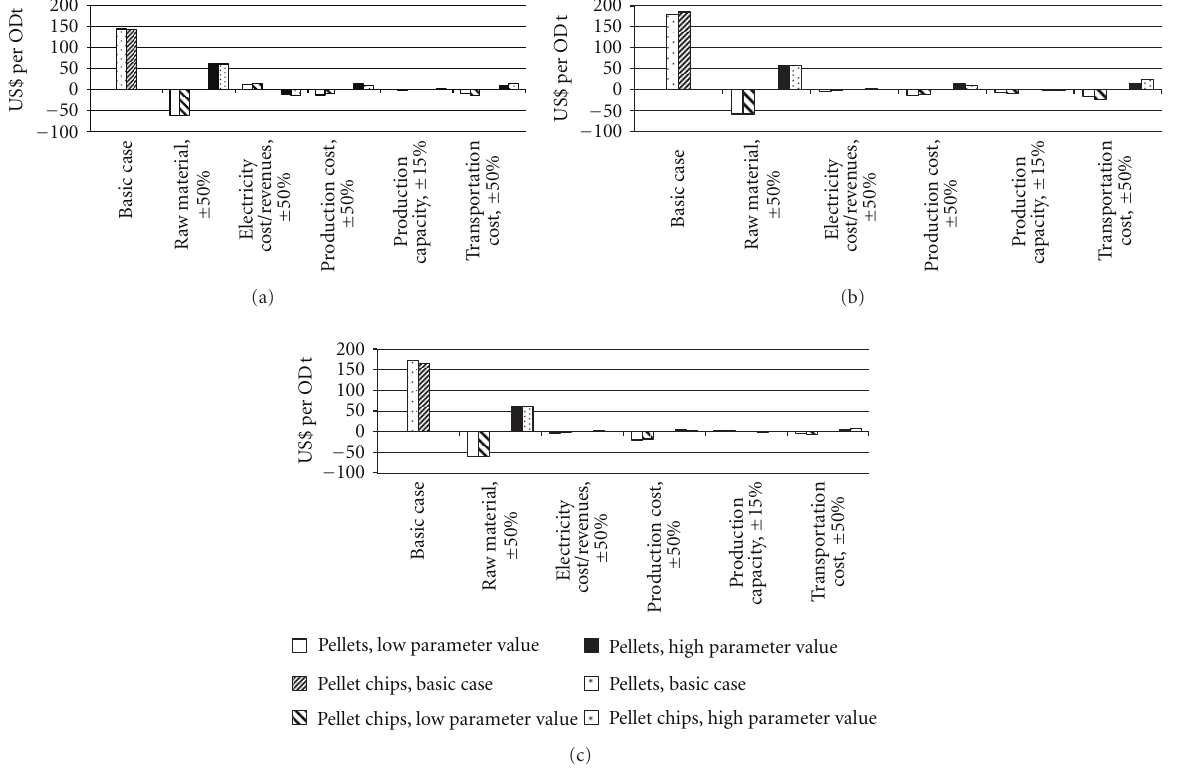
Figure 3: Results of the sensitivity analysis for the three plant sites—Lycksele (a), Vilhelmina (b), and V¨ann¨as (c)—for pellet production (1) and pellet chip production (2). The following parameters were varied: raw material cost, electricity cost/electricity revenues, production cost, transport costs and product price ( ± 50%), and productive capacity ( ±